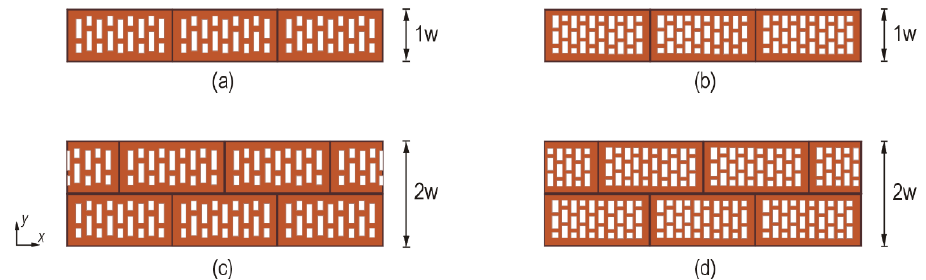
Figure 3. Considered types of wall: ( a ) 1w_B18, ( b ) 1w_B30, ( c ) 2w_B18, ( d ) 2w_B30.